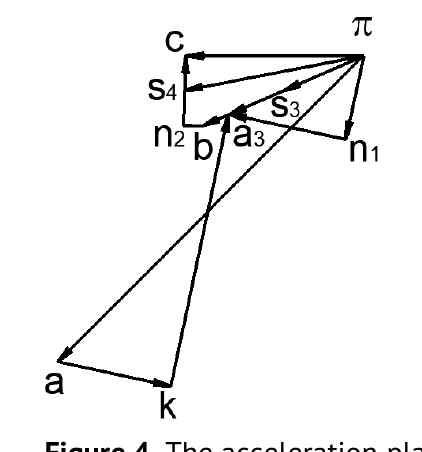
Figure 4. The acceleration